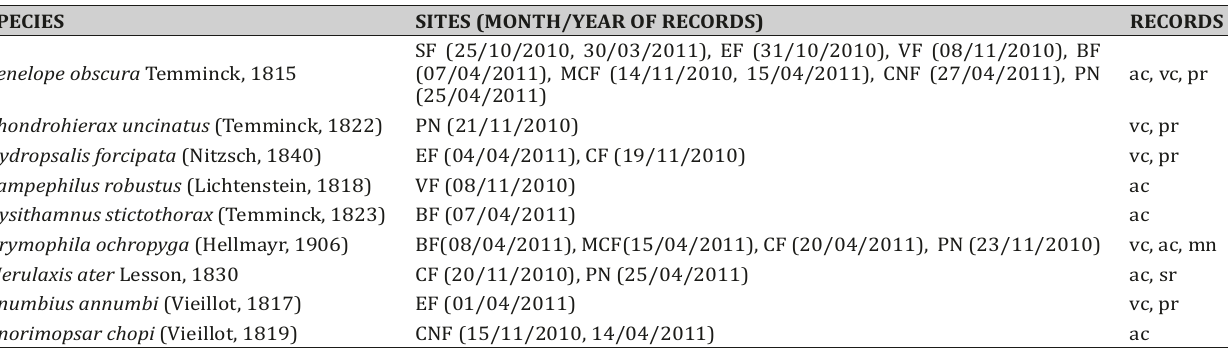
Species assigned statewide to near threatened (NT) according to the list of Endangered Fauna of the State of São Paulo. Records: vc = visual contact; ac = audio contact; mn = bird captured with mist net; pr = photo record; sr = sound record (bird